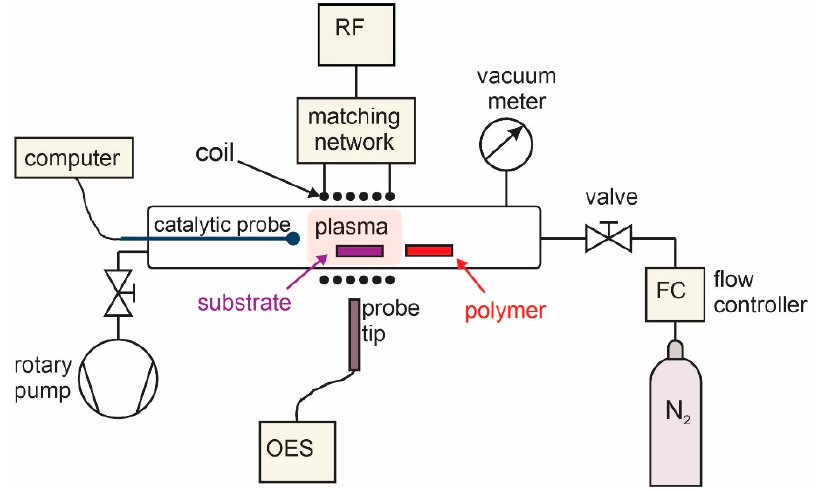
Figure 1. Experimental set-up.